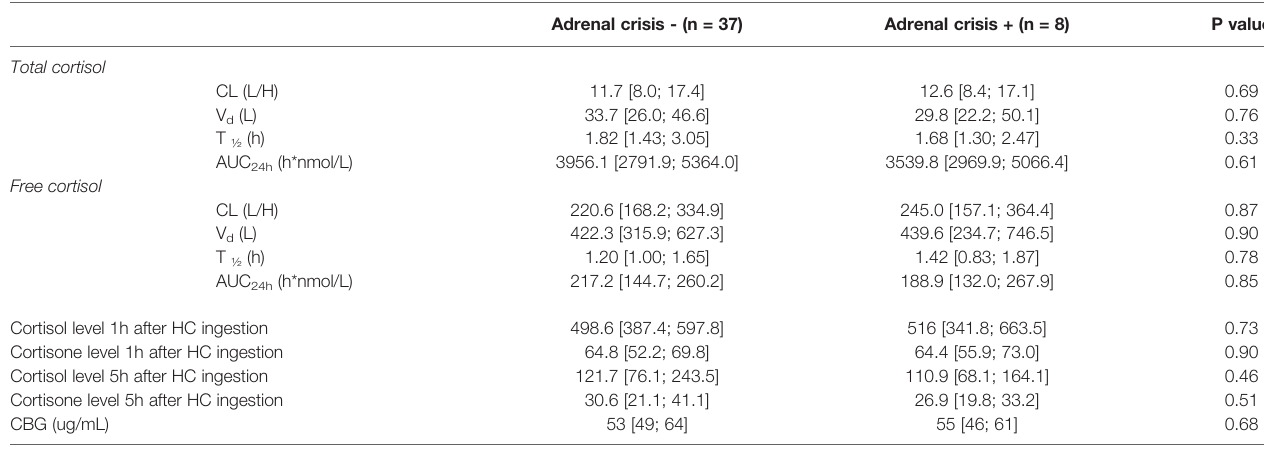
TABLE 3 | Pharmacokinetic parameters of free cortisol and total cortisol as well as plasma concentrations of cortisol, cortisone and CBG on the lower dose hydrocortisone (0.2-0.3 mg/kg/day) in patients with or without a history of an adrenal crisis.